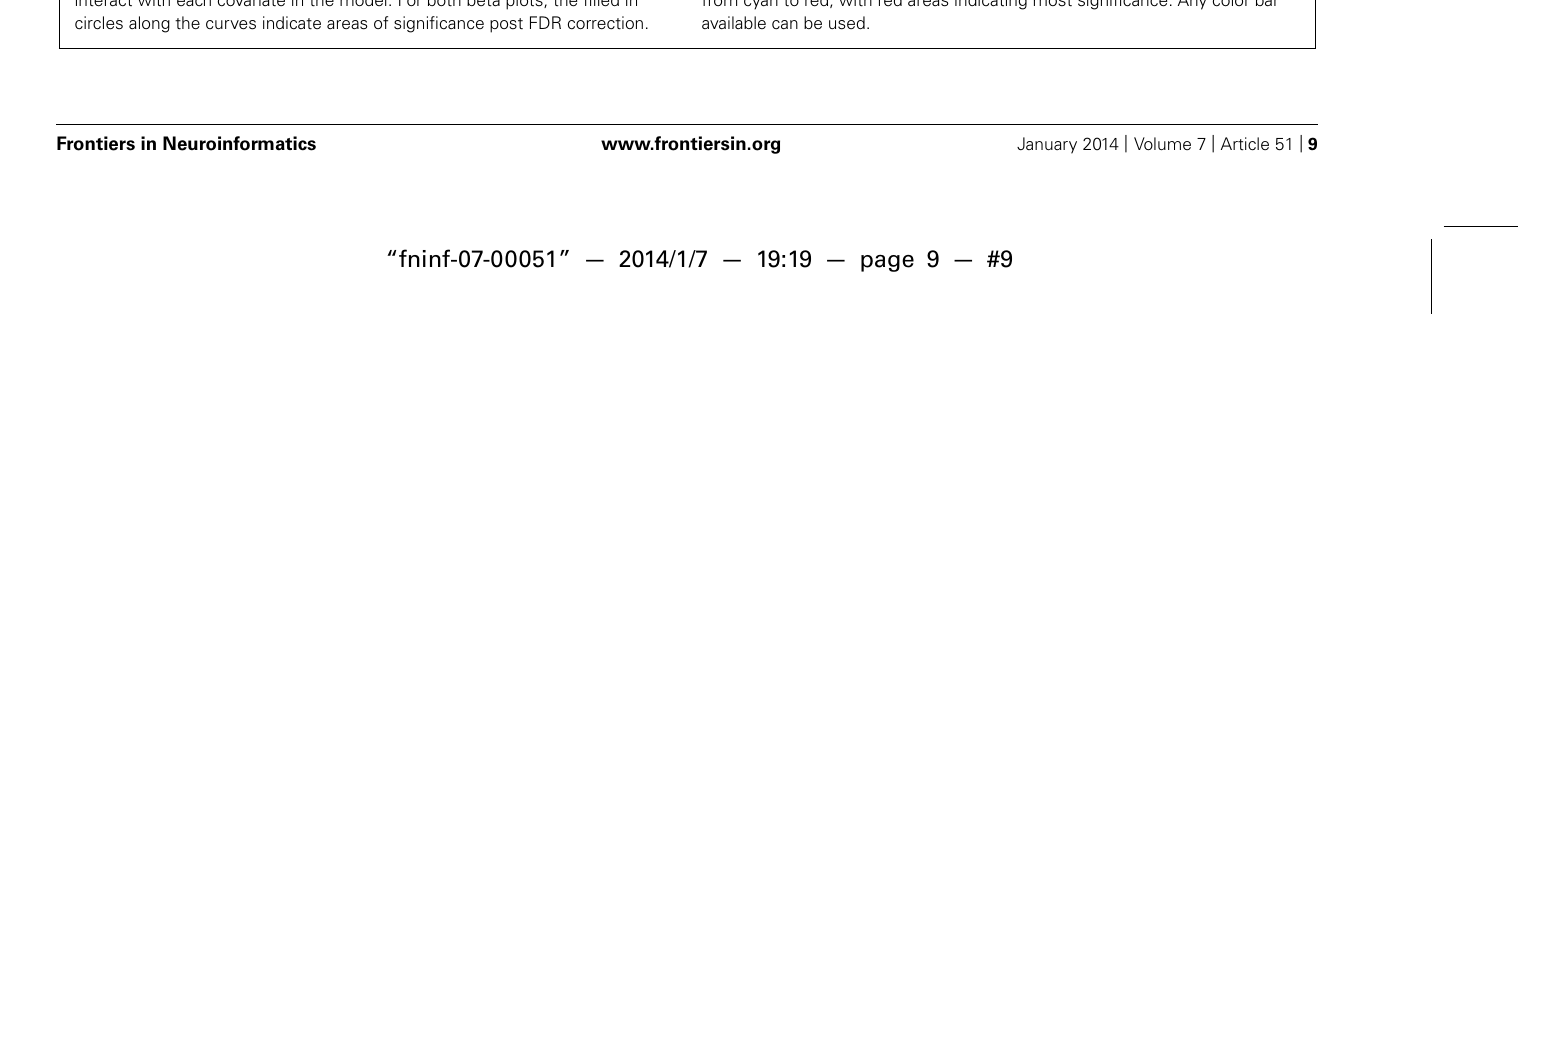
FIGURE 8 | Examples of possible plots from functional analysis of diffusion tensor tract statistics (FADTTS) and MergeStatWithFiber. (A) Plot the raw data. (B) Output of FDR corrected local-log p -values along the length of the fiber tract. (C) Separate beta plots for all of the covariates entered into the model and how they interact with each diffusion parameter. (D) Separate beta plots for how all the investigated diffusion parameters interact with each covariate in the model. For both beta plots, the filled in circles along the curves indicate areas of significance post FDR correction.